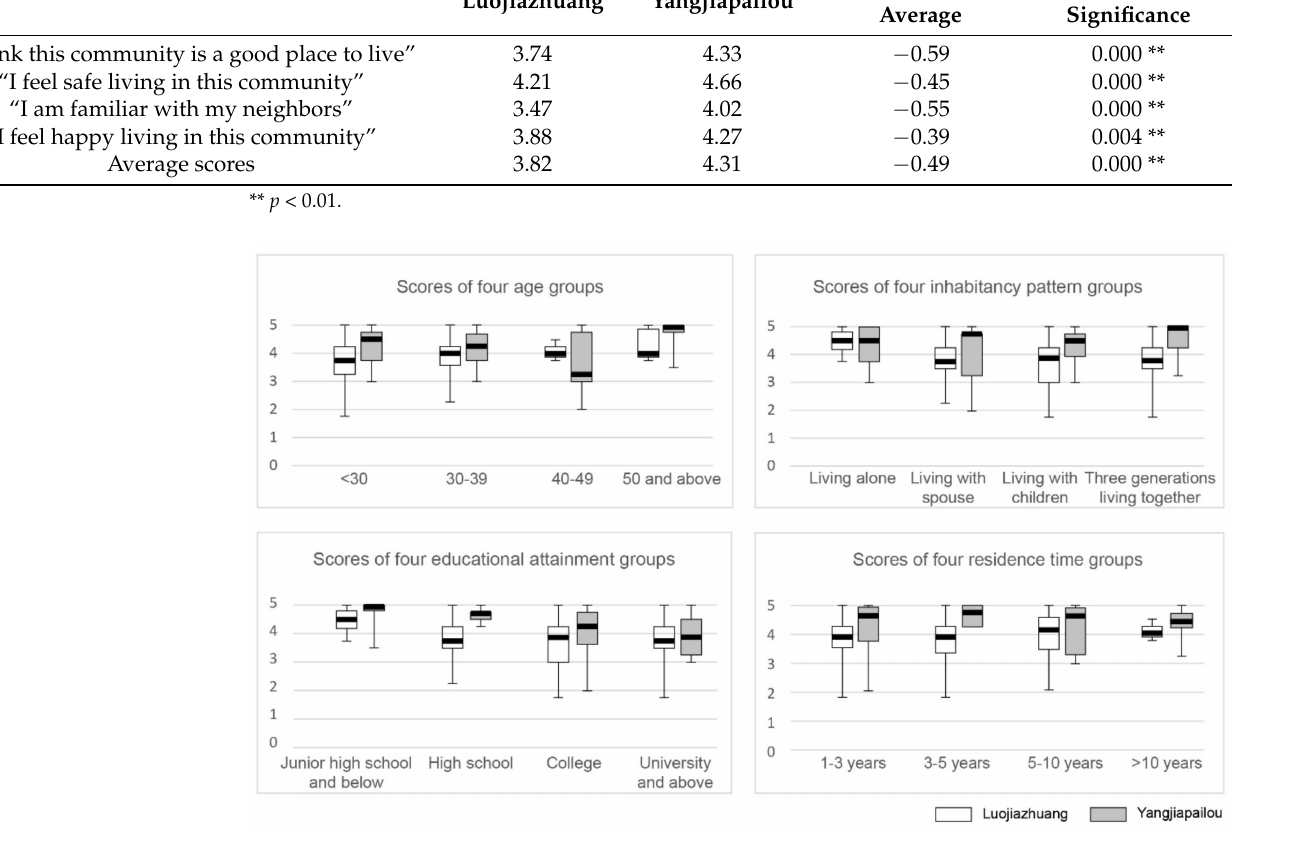
Figure 11. Box plot of residential satisfaction in Luojiazhuang and